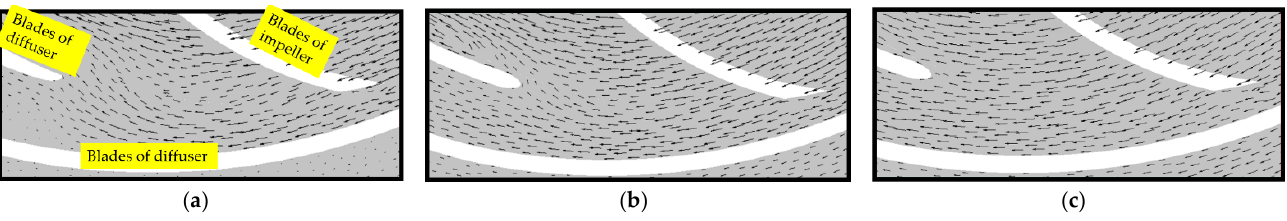
Figure 7. Velocity vector diagram of the interface between impeller and vaned diffuser. ( a ) Velocity vector diagram of the interface between impeller and vaned diffuser at Q = 1 m 3 ·h −1 ; ( b ) velocity vector diagram of the interface between impeller and vaned diffuser at Q = 3 m 3 ·h −1 ; ( c ) velocity vector diagram of the interface between impeller and vaned diffuser at Q = 5 m 3 ·h −1 .